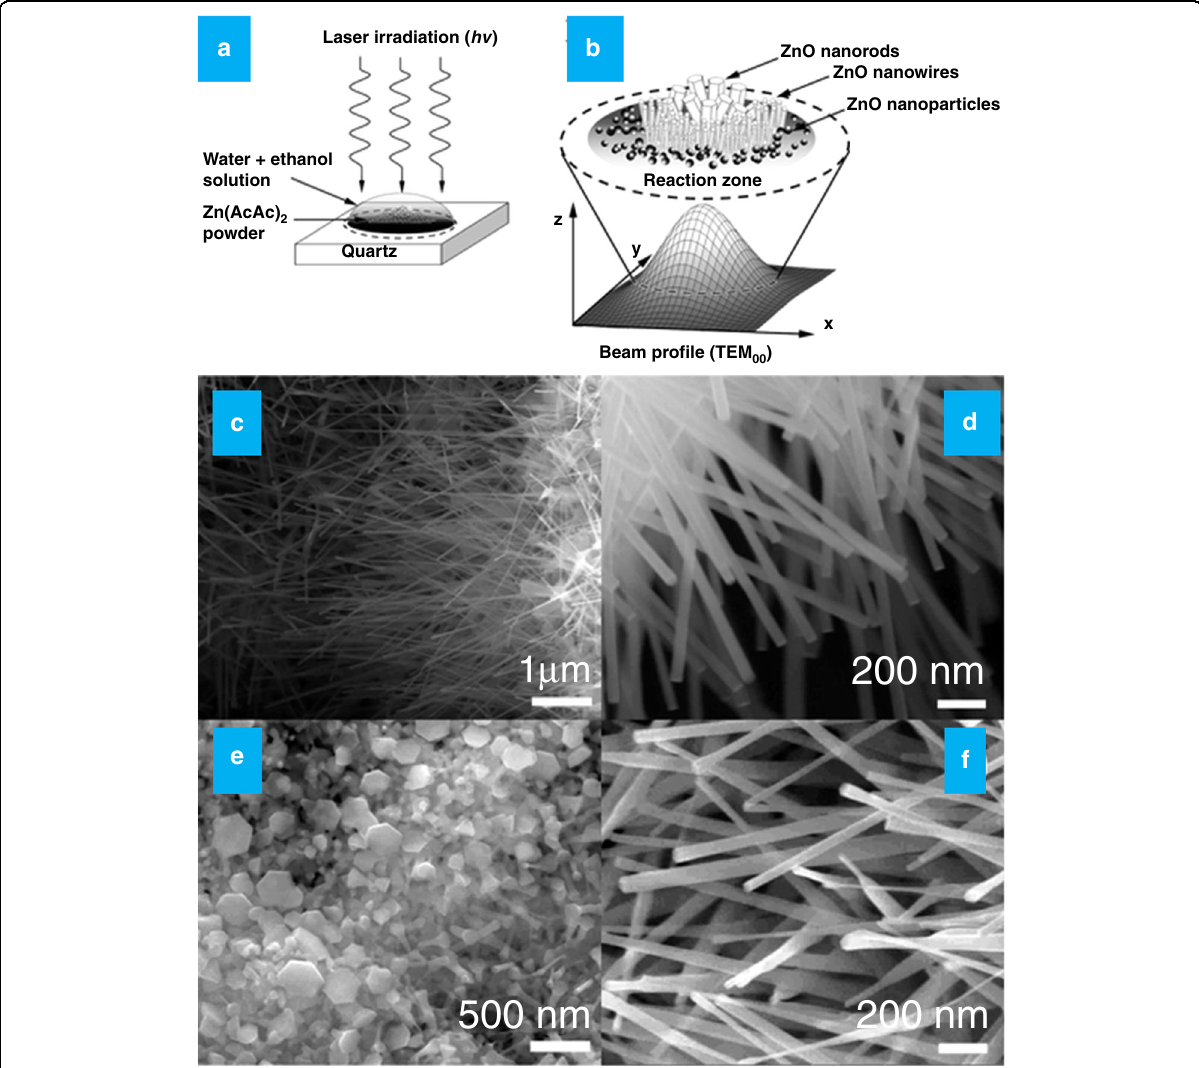
Fig. 12 CO 2 laser assisted synthesis of ZnO nanostructures. a , b Schematic illustration of the synthesis (laser-induced decomposition) and reaction zone of various ZnO nanostructures, c , d SEM images of ZnO nanowires after laser irradiation with a pulse energy of 20 W for 5 s, and e , f SEM images ZnO nanonails after laser irradiation with a pulse energy of 20 W for 2 s 92 . Copyright (2021) American Chemical